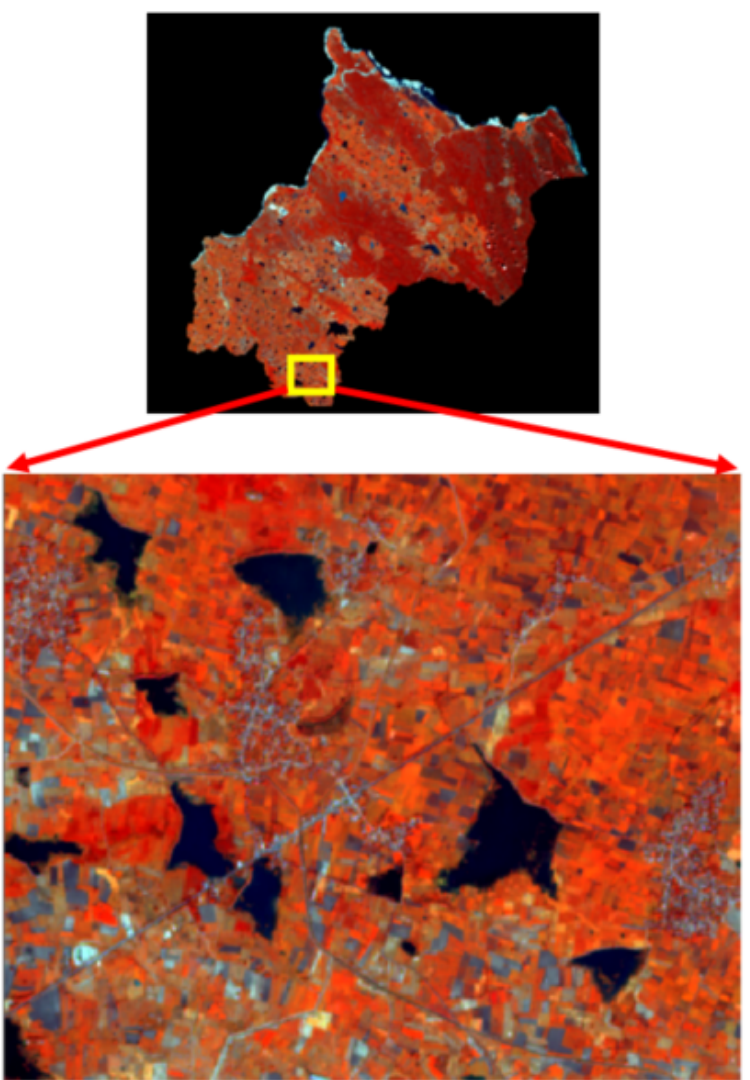
Figure 4. Subset image from district image, dated 10 November 2019.